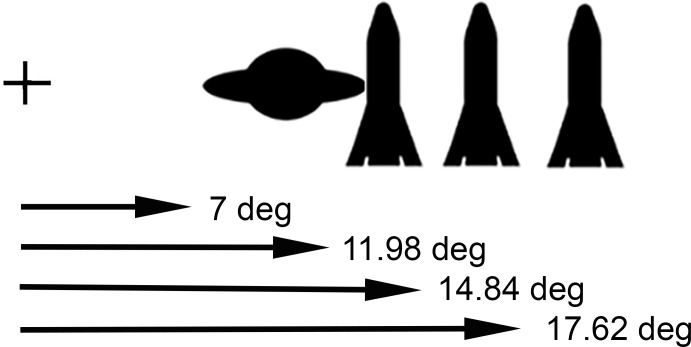
Illustration of the task used in Experiment 2. The target appeared closer to fixation (7° of visual angle) than a preceding cue: near (11.98°), moderate (14.84°), or far (17.62°) distance from fixation.